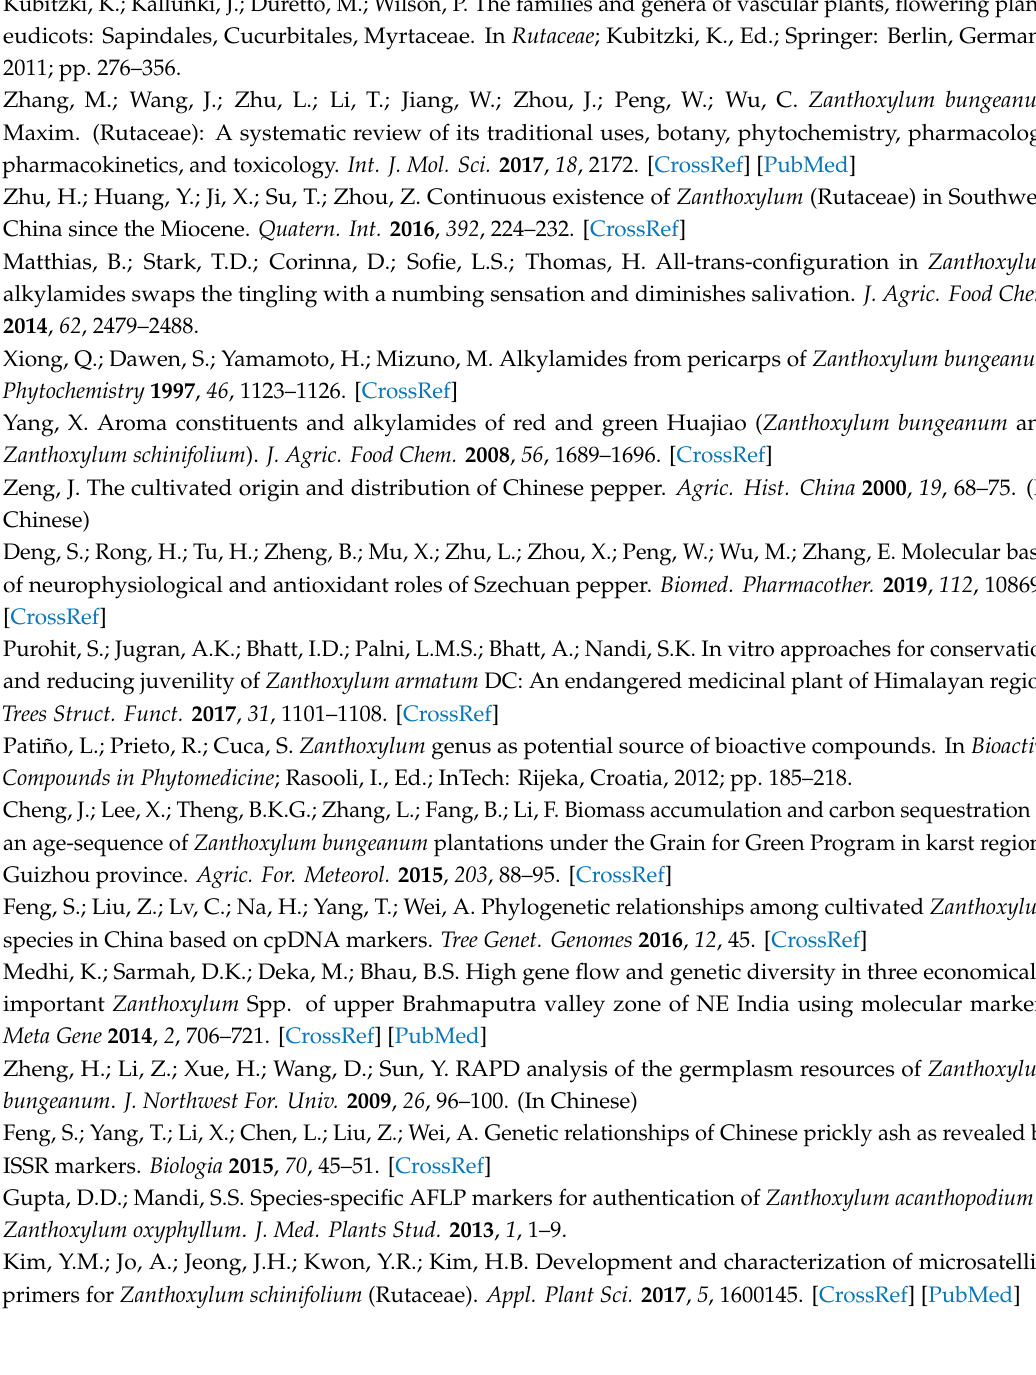
Table S1: Sampling information of Chinese